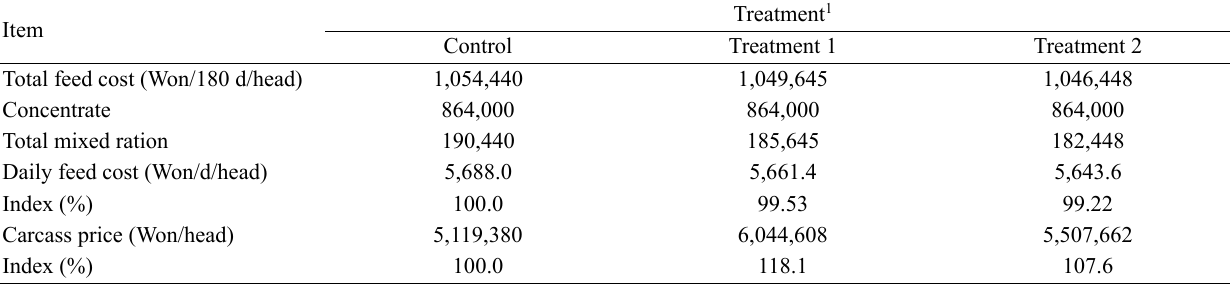
Table 6. Substitution effect of a total mixed ration by medicinal plant by-products on the economic efficacy in the late fattening period of Hanwoo steers